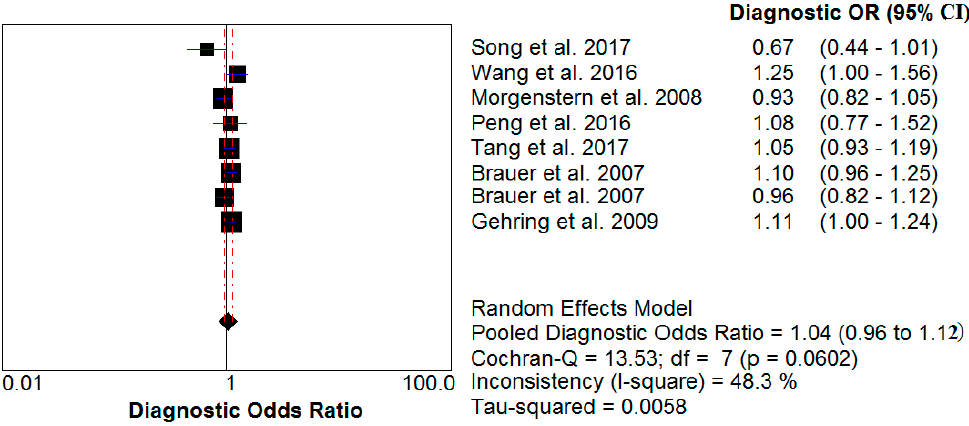
Figure 3. Relative risk of PM 2.5 impact on human skin.